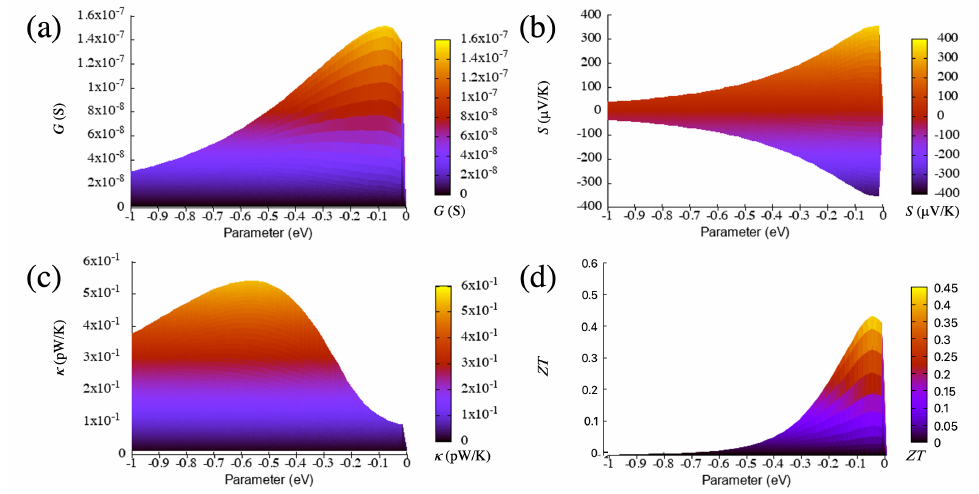
Figure 3. Electrical conductance ( a ), Seebeck coefficient ( b ), electronic thermal conductance ( c ) and figure of merit ( d ) as a function of the coupling parameter for the wedge–edge configuration (side view of Figure 2). The temperature is 300